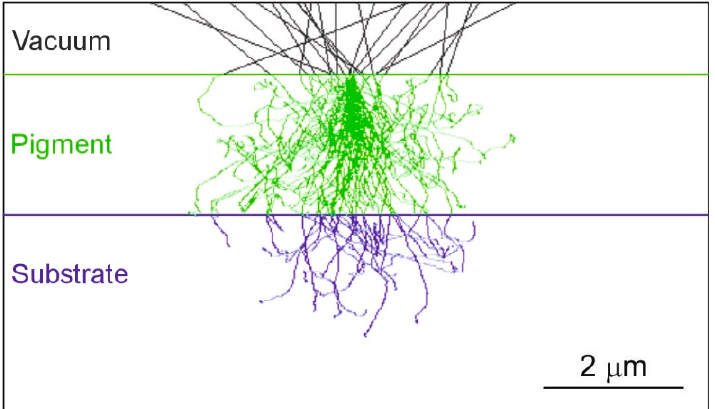
Figure 2. Middle section of the simulated electron trajectories in a prismatic shape Egyptian blue fragment, 2.0 µm thick, with an electron beam energy of 20 keV. The trajectories of electrons in interaction with the sample (green), with the carbon substrate (blue) and the backscattered electrons (black) are clearly seen. The electron probe (size of 5 nm, zero divergence) is focused on the upper side and in the middle position with respect to the prismatic pigment particle.